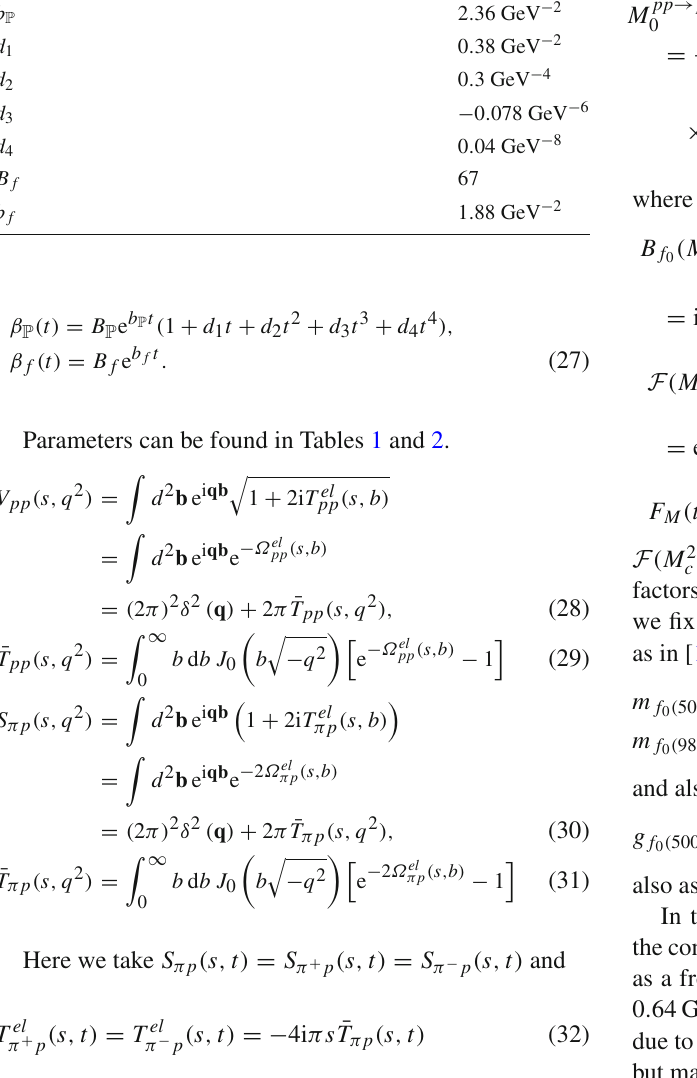
Table 2 Parameters for pion–proton elastic scattering amplitude Parameter Value B P 26 .